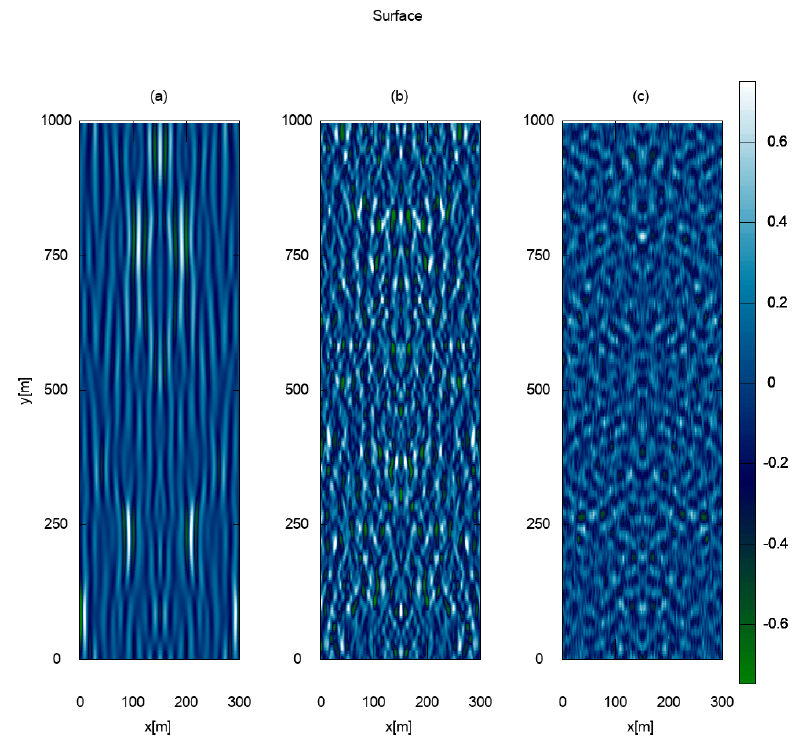
Figure 4. The evolution of surface η ( x , y , t ) in time. The color shows the amplitude of the waves in meters. Panel ( a ) corresponds to the almost initial surface at time t ≈ 2 min. Panel ( b ) corresponds to the surface at time t ≈ 1 h, and Panel ( c ) corresponds to the surface at time t ≈ 96 h. Several films are available for more